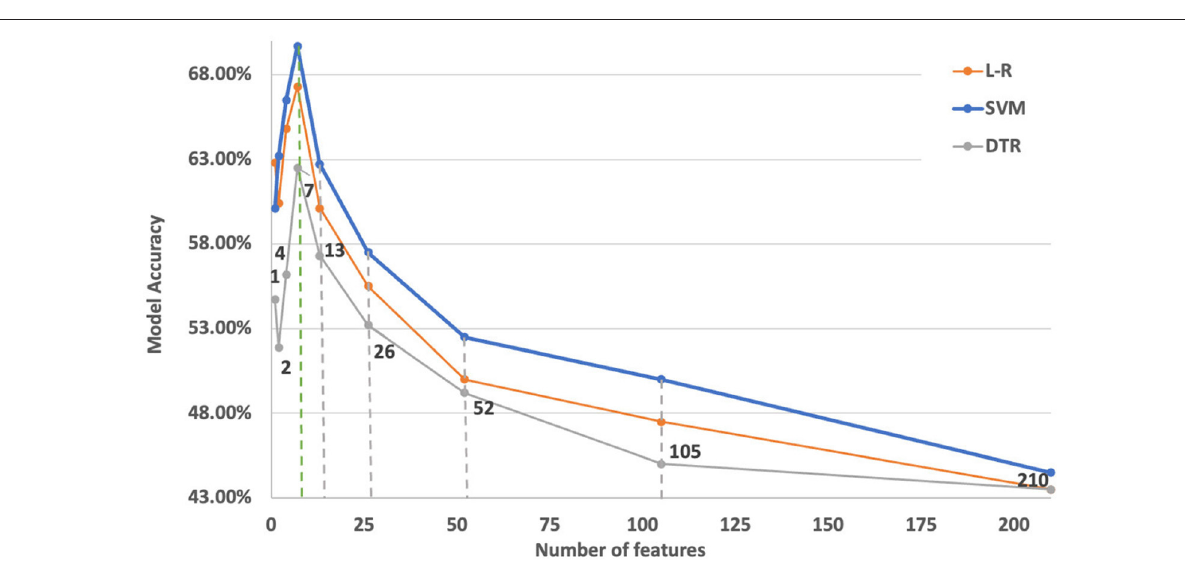
FIGURE 3 | Optimal number of features against model performance with data coming from the Simultaneous Task EEG workload (STEW) dataset. The dashed lines indicate the number of feature considered in the iteration. It can be seen that the optimal number of top features to select is around seven indicated with green dashed line which also acts as a stopping